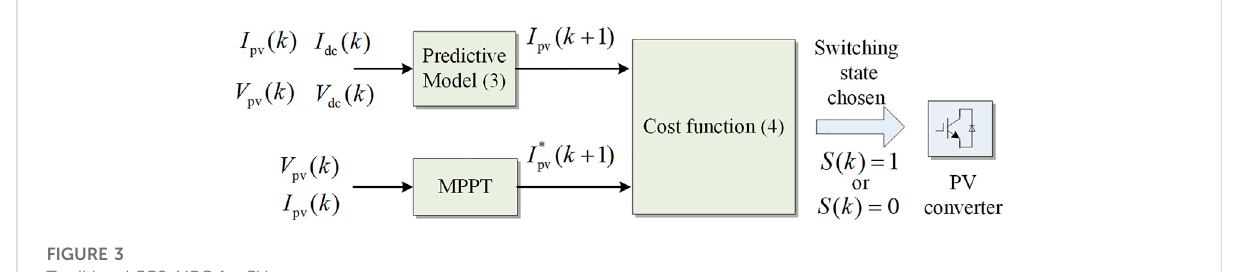
FIGURE 3 Traditional FCS-MPC for PV sources.